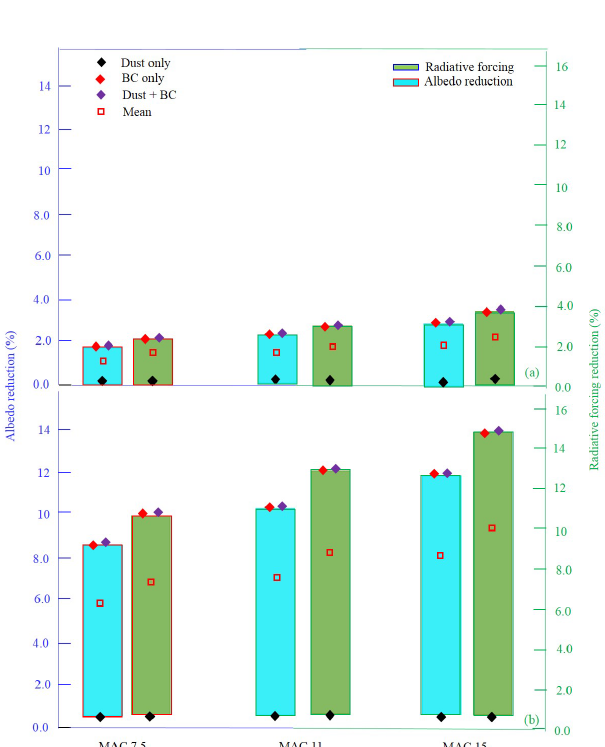
Black carbon and dust